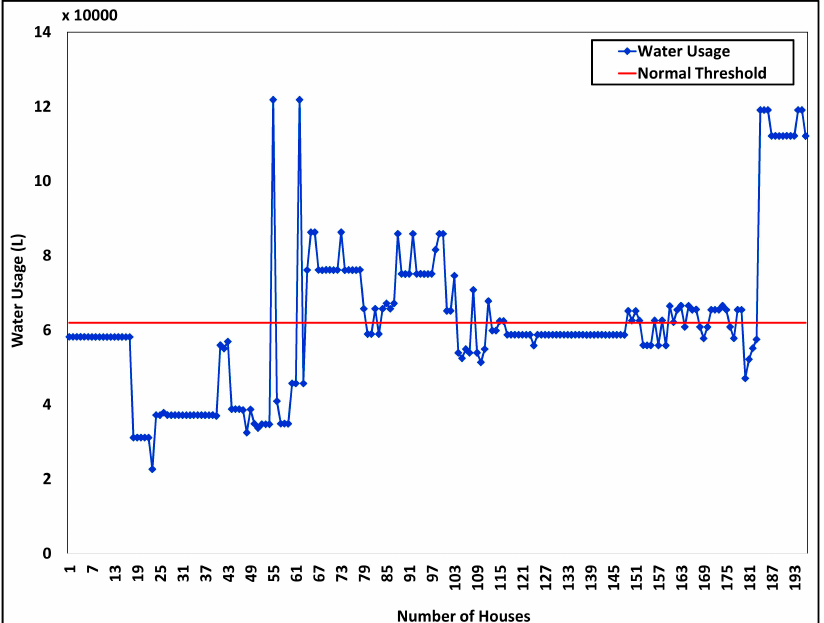
Figure 8. Water consumption analysis of Surrey, Canada.